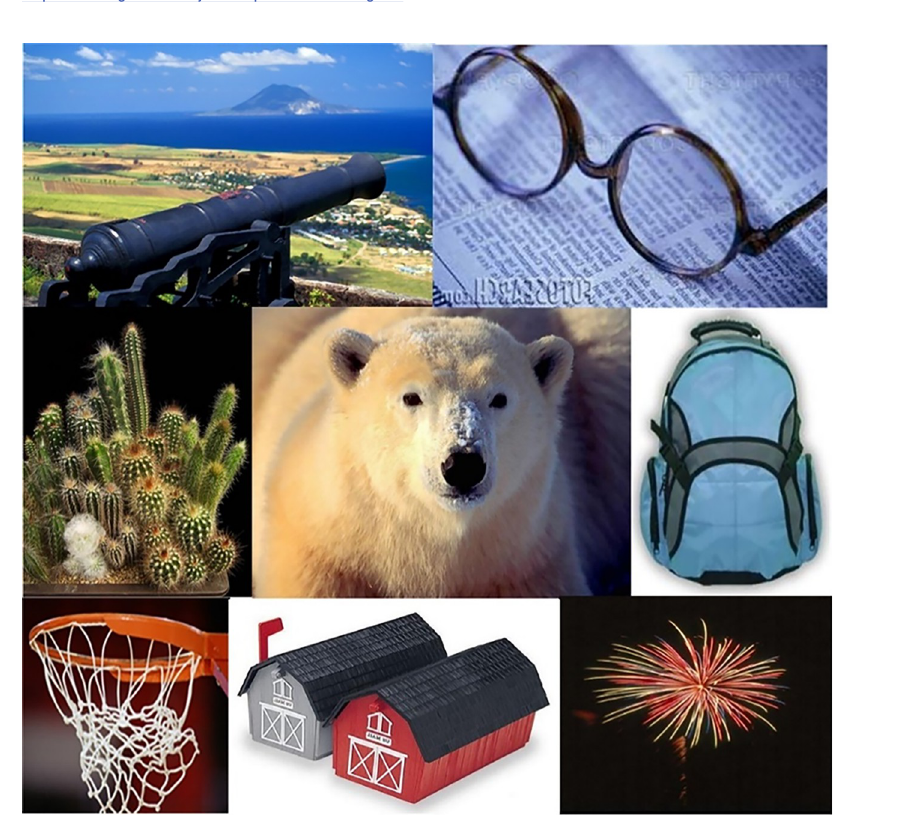
Fig 18. Sample images of the Caltech-256 dataset